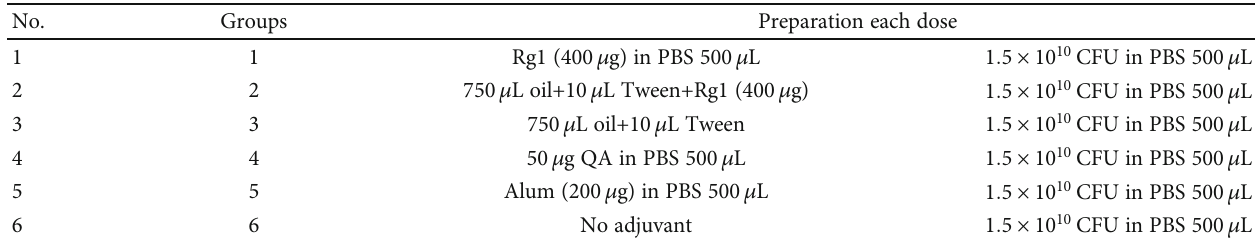
Table 1: Adjuvant vaccines used in Experiment A.